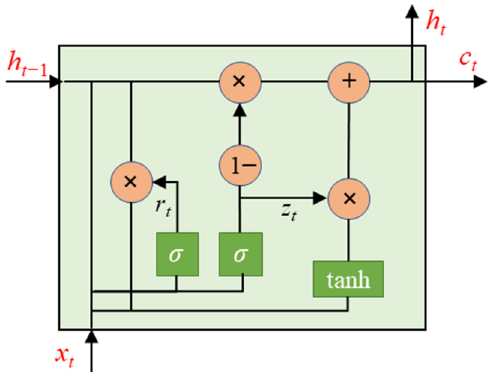
Figure 6. GRU gated neuron structure.